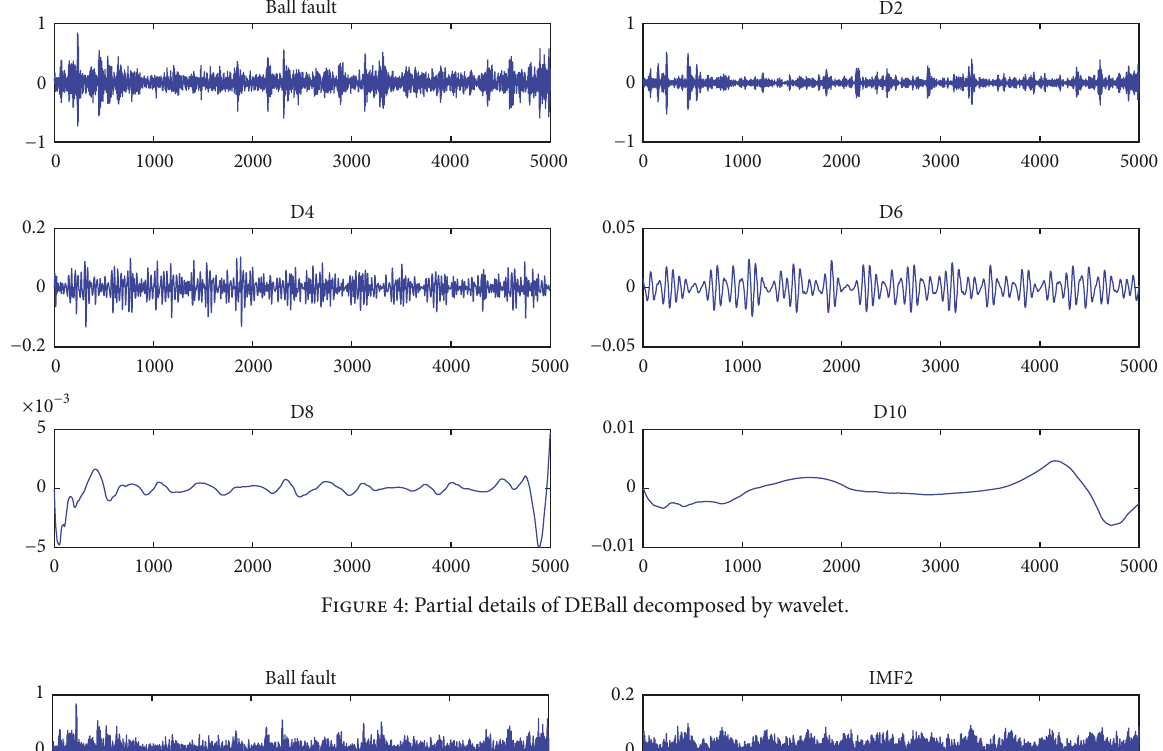
Figure 4: Partial details of DEBall decomposed by wavelet.